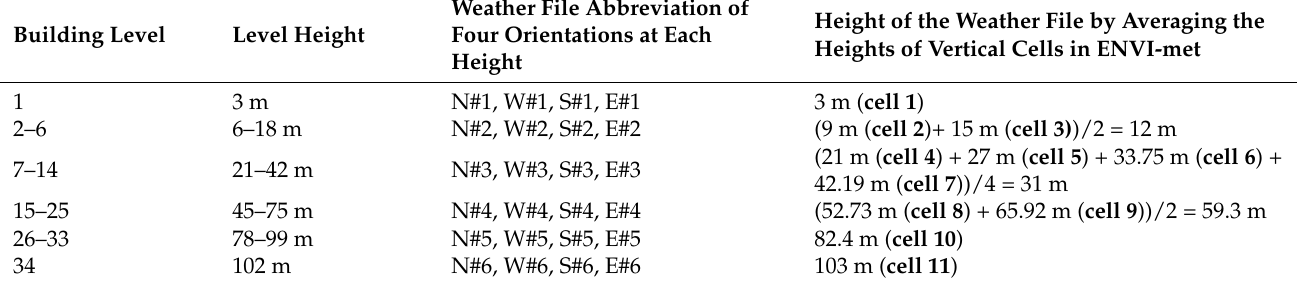
Figure 7. South view of HSJG and its zones in COMFIE. Table 5. The 24 weather files for building energy simulation based on position (with the corresponding cells in